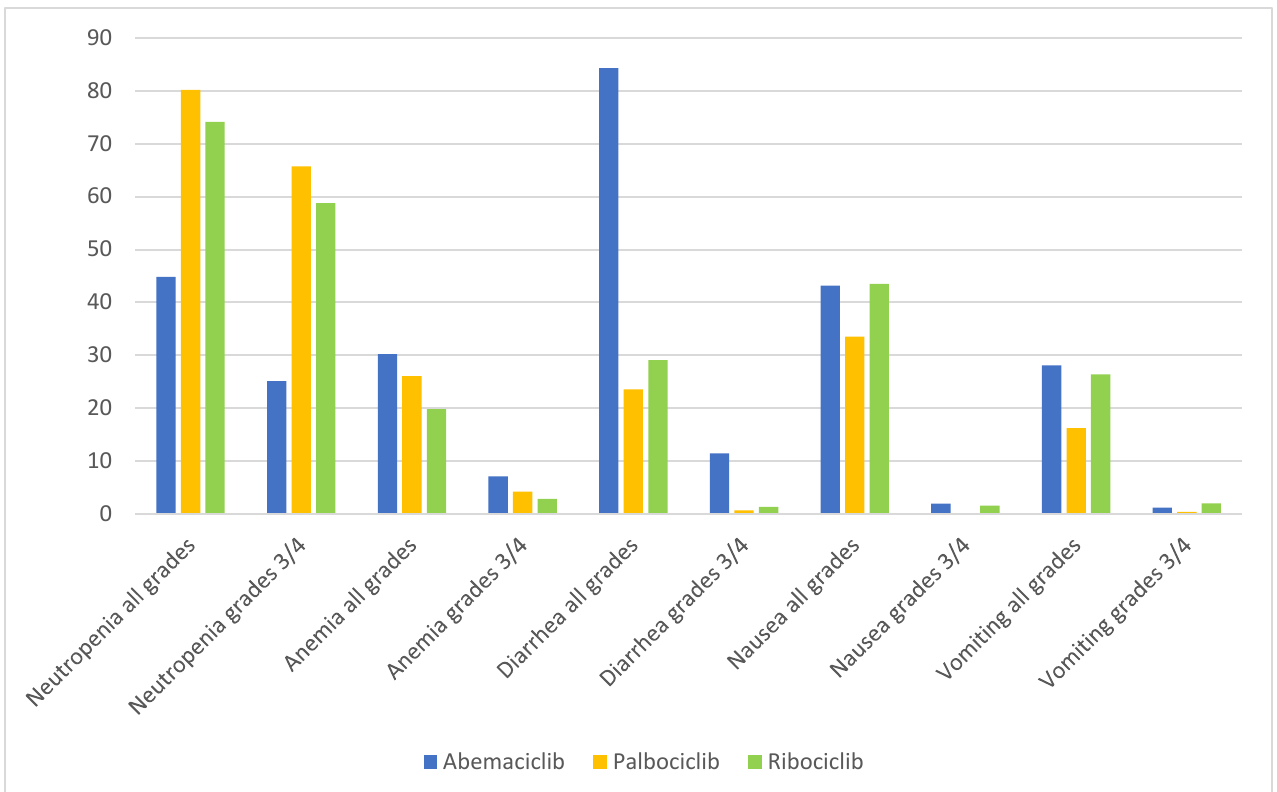
Figure 2. Relevant adverse events from phase III trials MONARCH-2 and -3 [23,24], PALOMA-2 and -3 [18,19] and MONALEESA-2, -3 and -7 [20–22] on average in percent.